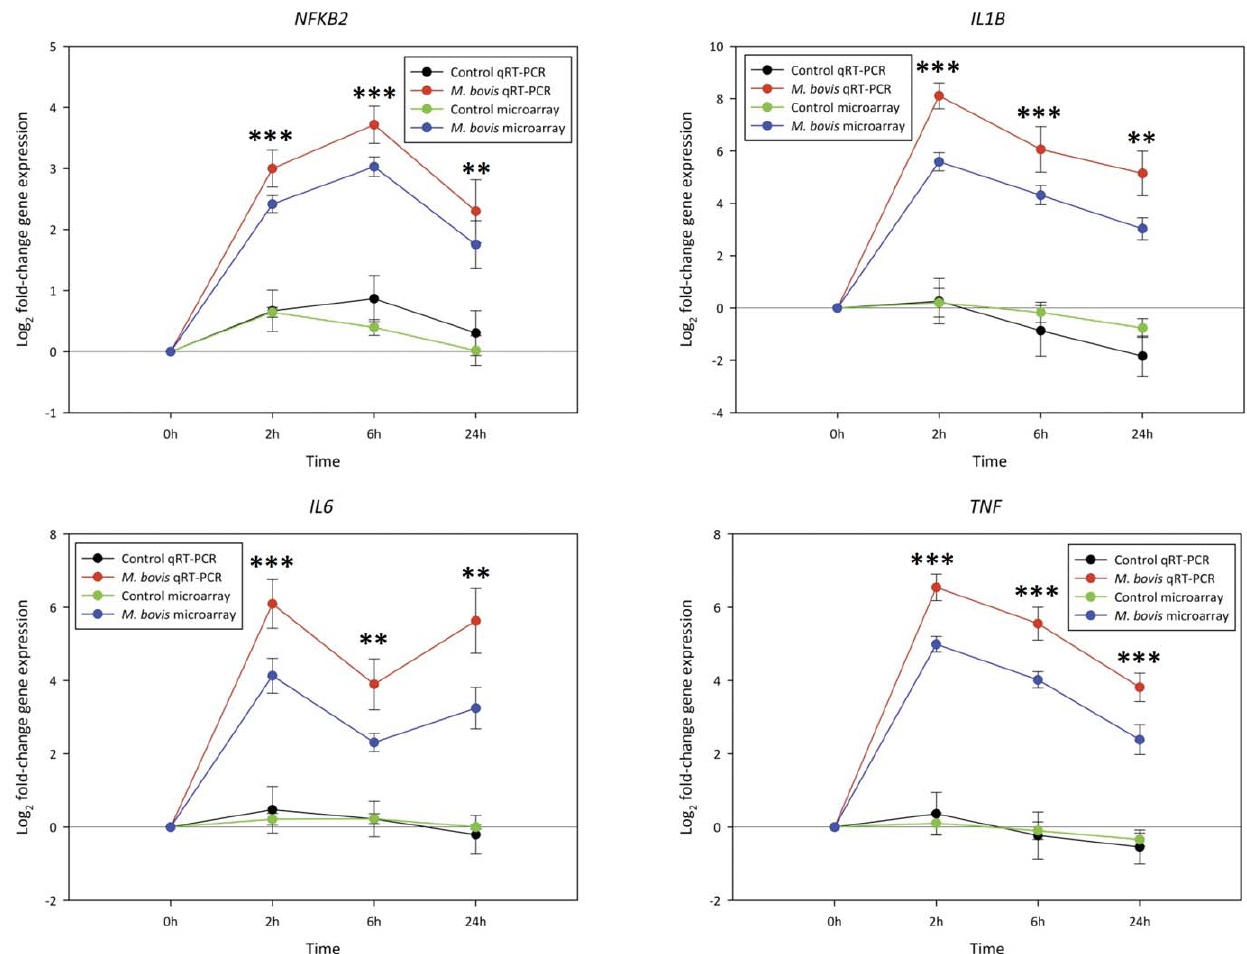
Figure 7. Real time qRT-PCR analysis of the IL1B , IL6 , NFKB2 and TNF genes following M.bovis challenge. Log 2 fold-changes in expression in the M. bovis -challenged MDM relative to the non-challenged control MDM at all three time points are shown. For comparison, the expression profiles for these genes based on the microarray data are also shown. The significance of the fold-changes in expression for each gene based on the real time qRT-PCR analysis only are denoted by asterisks in the figure (* P # 0.05, ** P # 0.01, *** P # 0.001). The fold-changes calculated for each gene from the microarray data in the M. bovis -challenged MDM for each gene at each time point were significant (adjusted P -value # 0.05). In addition, the log 2 fold-change in expression for the control MDM at each time point relative to the 0 hour control MDM are also shown for both the microarray and real time qRT-PCR data; no significant differences in gene expression between the control MDM relative to the 0 hour control was observed for these genes at each time point ( P $ 0.05). doi:10.1371/journal.pone.0032034.g007 PLoS ONE |